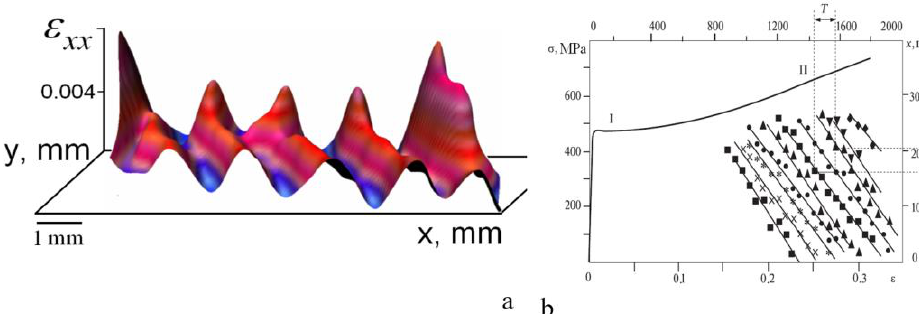
Fig. 1. A typical pattern of localized plastic flow for the case of linear work hardening (a); an expla- nation for the estimation of autowave length and autowave period with the help of X-t diagram